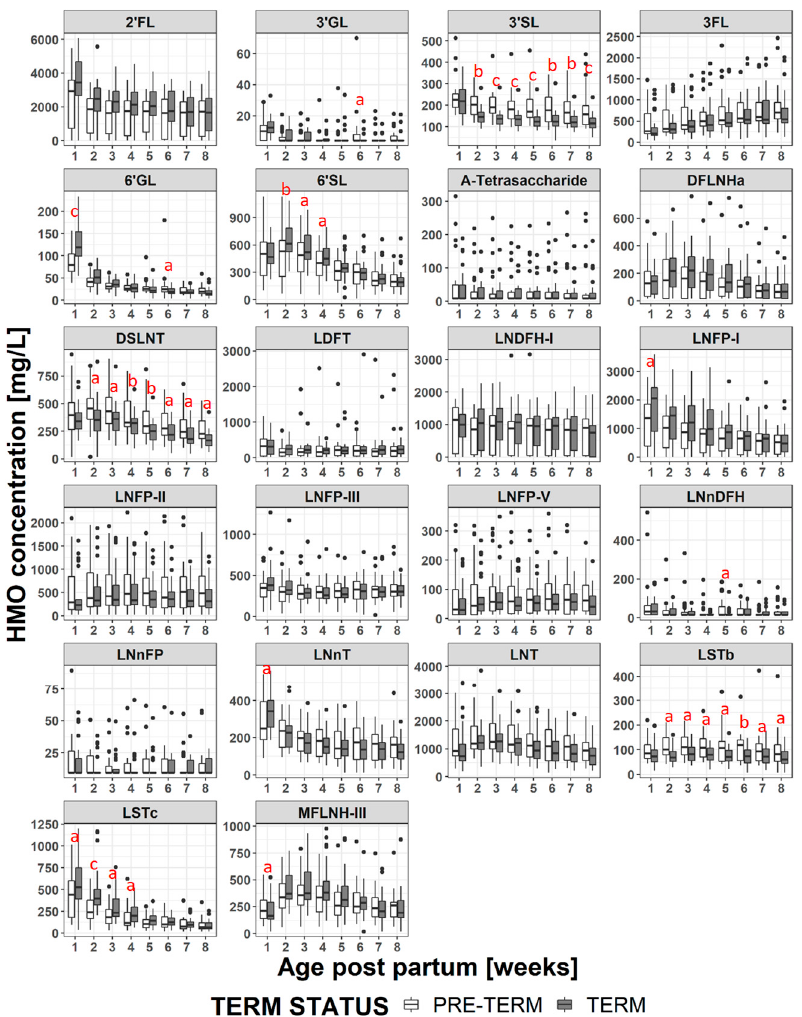
Figure 3. Mean concentration of each HMO at each visit for term (grey) and preterm (white) infants, letters indicate if difference between term and preterm is significant; a: p < 0.05, b: p < 0.005, c: p < 0.0005.